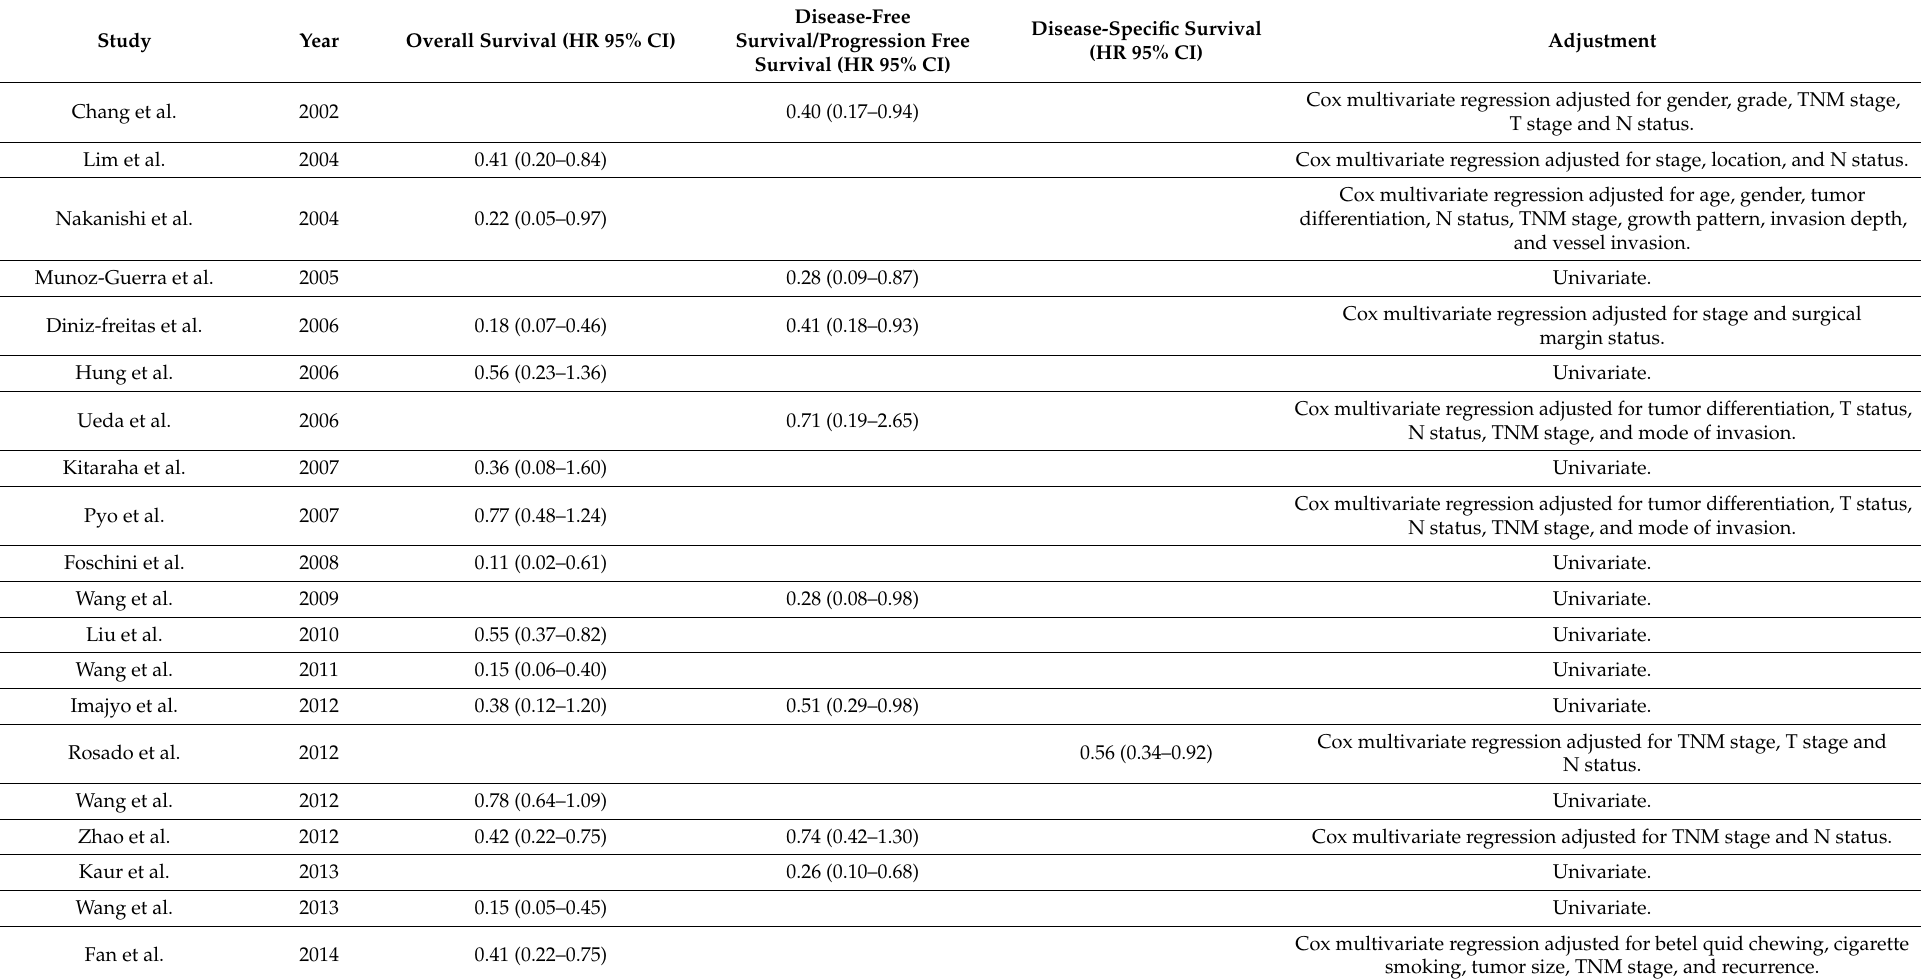
Table 2. Data synthesis for pooled analysis and adjustments for each included